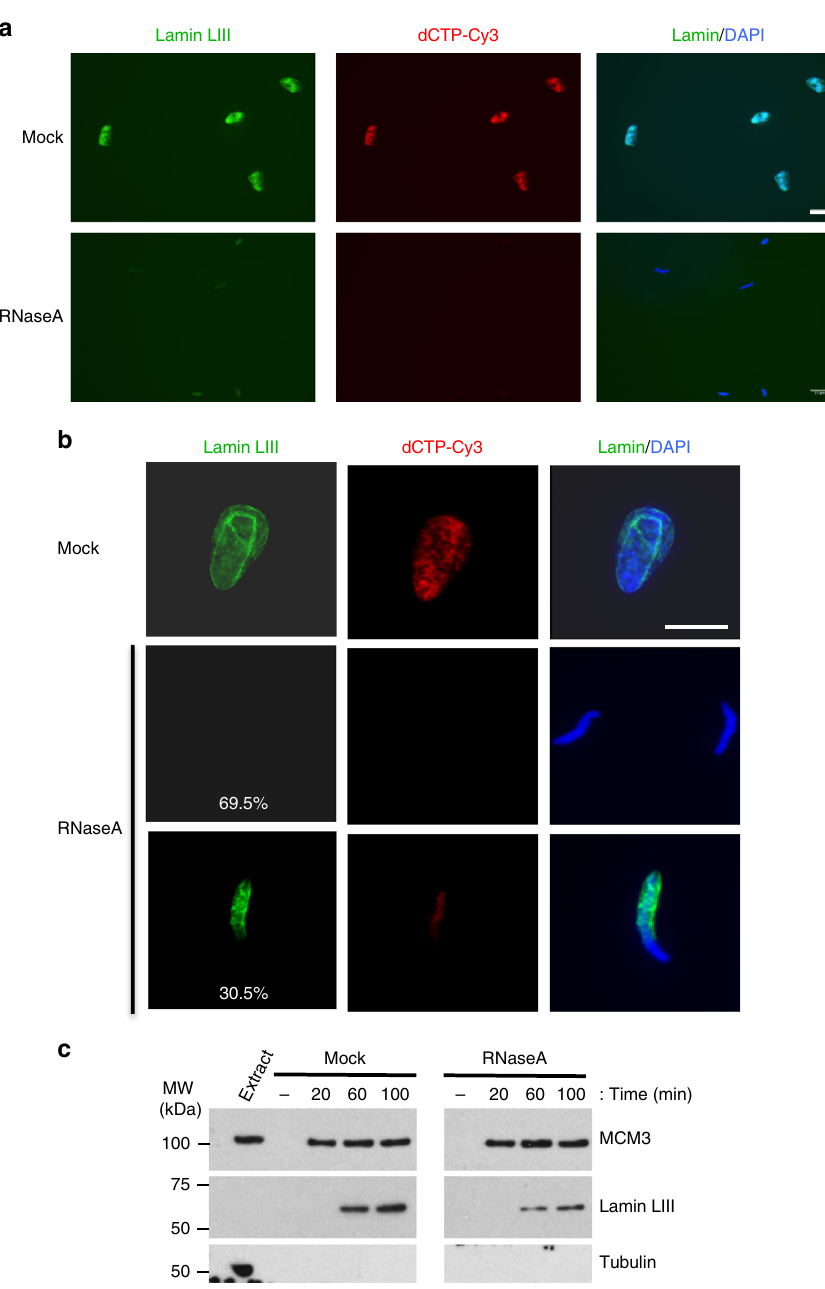
Fig. 2 The nuclear architecture is affected when assembled in RNA-depleted egg extracts. a Immuno fl uorescence analysis of lamin LIII accumulation (green) in a representative population of nuclei fi xed after incubation in mock- or RNase A-treated X . laevis egg extracts for 60 min. DNA synthesis was monitored by dCTP-Cy3 incorporation (red), and DNA was stained with DAPI (blue). Scale bar, 17 μ m. b Higher magni fi cation of representative nuclei from the experiments described in a . Lamin LIII could not be detected in 70% of nuclei assembled in RNA-depleted egg extracts and its accumulation was abnormal in the other 30%. Scale bar, 17 μ m. c Western blot analysis of nuclear extracts prepared from sperm nuclei at different time points